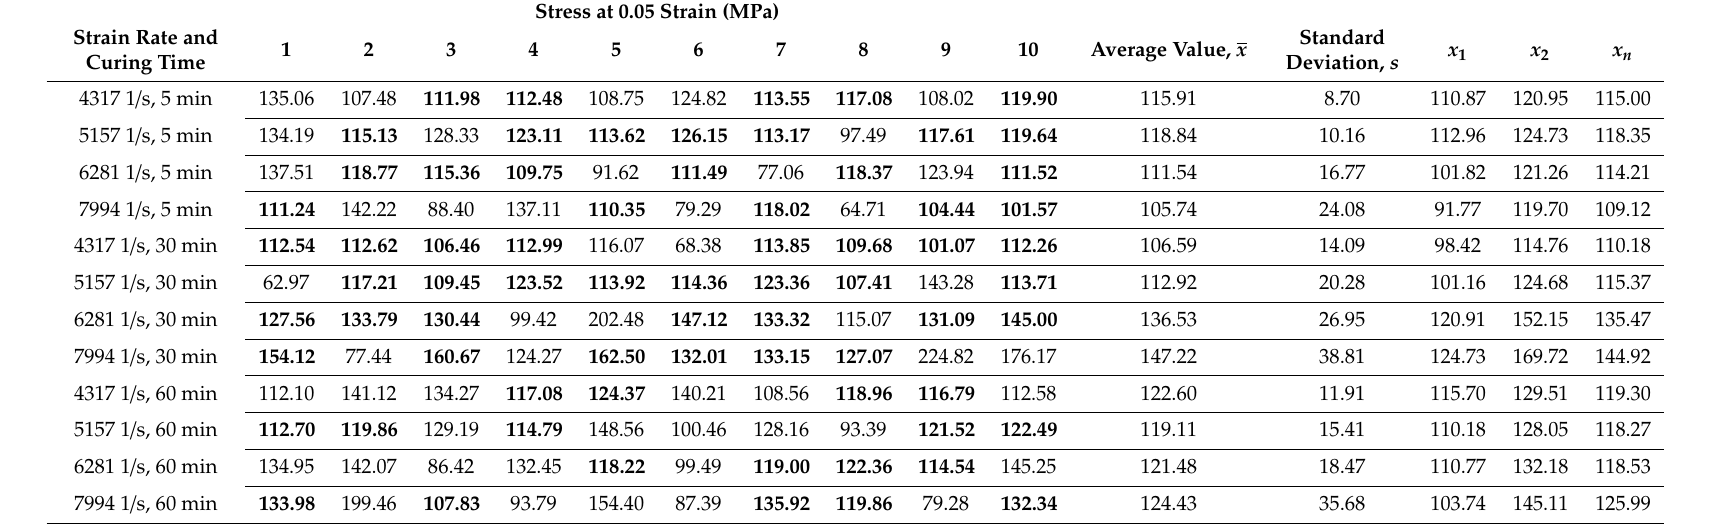
Table 4. Statistical analysis results for the SHPB tests. Stress at 0.05 Strain